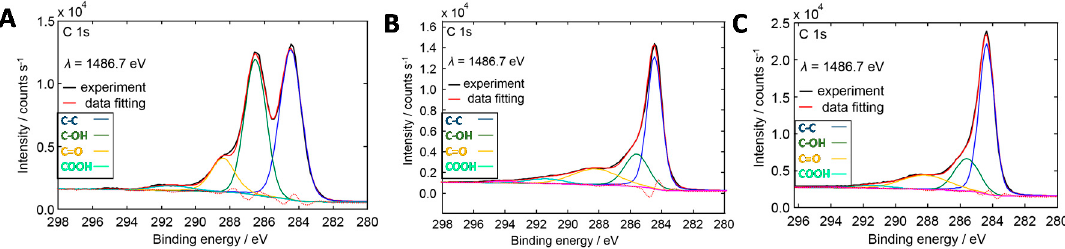
Figure 3. X-ray photoelectron high-resolution spectra of the C 1s band region in: ( A ) graphene oxide (GO); ( B ) chemically reduced graphene oxide (CRGO); ( C ) graphene-sulfur composite 2 (GS2).